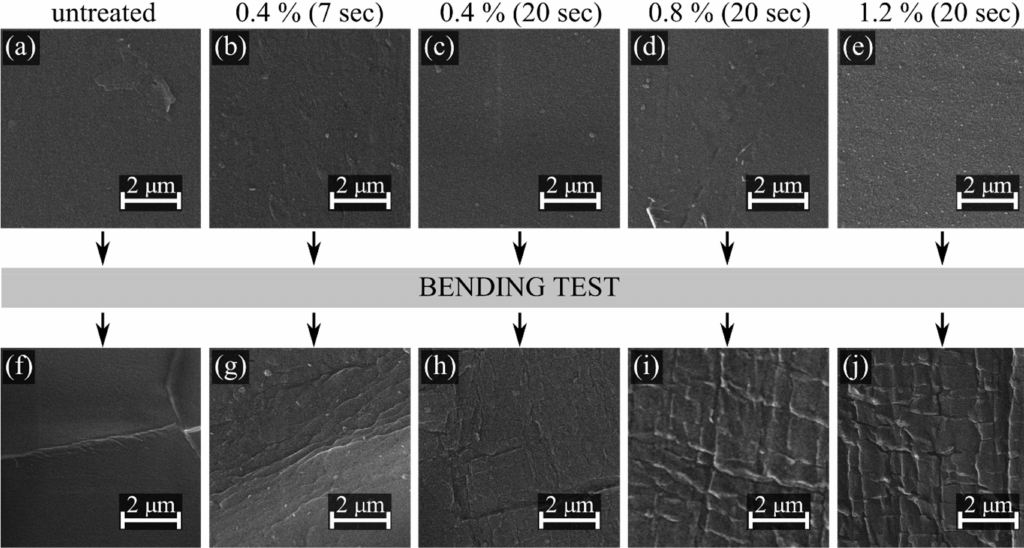
Figure 8. Surface topography of untreated and plasma-treated surface before the bending test; top row ( a ) to ( e ); and after the bending test: bottom row ( f ) to ( j ). The treatment time was 7, resp. 20 seconds and the composition of processing gas was 0.4, 0.8, resp. 1.2% of P-B in